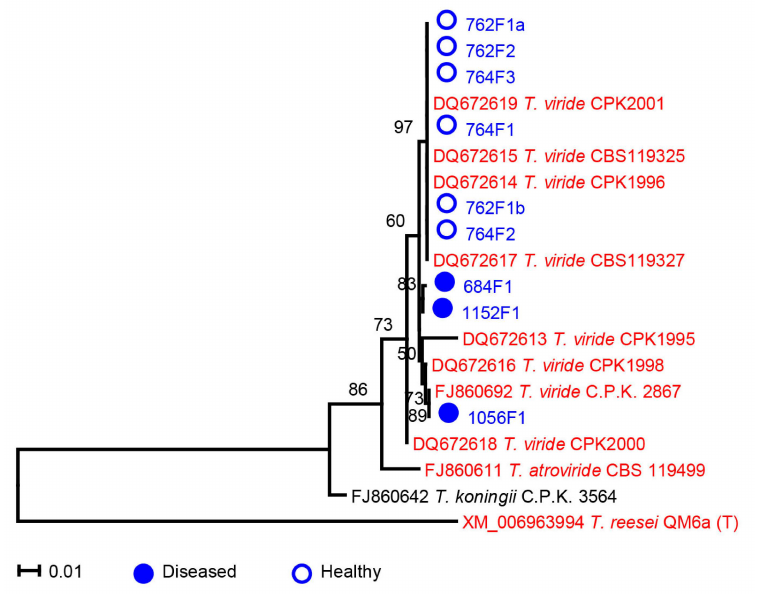
Figure 6. Phylogenetic tree of tef1 sequences of nine Trichoderma viride isolates and reference strains. The phylogenetic analyses were conducted in Mega 5 using the Tamura-Nei method [71] to compute evolutionary distances. The bootstrap values indicated at the nodes are based on 1000 bootstrap replicates. Branch values lower than 50% are hidden. Closed and open circles indicate isolates from Saprolegnia -infected (diseased) or healthy samples, respectively. Red, blue and black colors indicate strains from terrestrial/plant, aquatic and unknown sources of isolation, respectively. The scale bar indicates an evolutionary distance of 0.01 nucleotide substitution per sequence position. 11 sequences of good quality and at least 1200 bp of reference strains of Trichoderma were downloaded from GenBank; their strain names are preceded by the accession numbers. Strain name followed by “(T)” indicates type